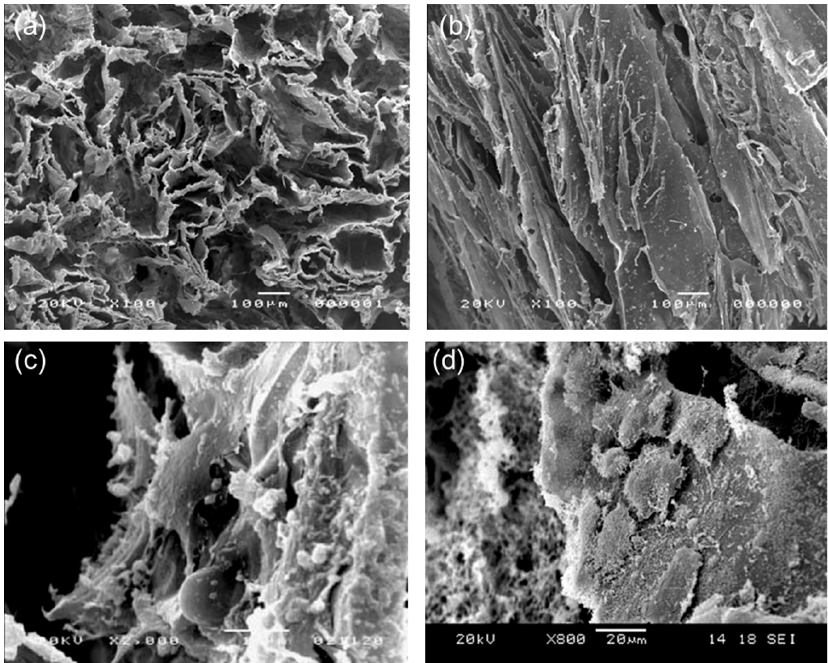
Figure 5. PDLLA/45S5 Bioglass ® scaffolds for possible application in lung tissue engineering: SEM micrographs showing the microstructure of the polymeric foam filled with 40 wt % of glass in sections: ( a ) orthogonal to pore direction; and ( b ) parallel to pore direction; and A549 cells seeded on the same scaffolds and incubated for: ( c ) three days; and ( d ) six days. Images from Verrier et al. [85] © Elsevier.